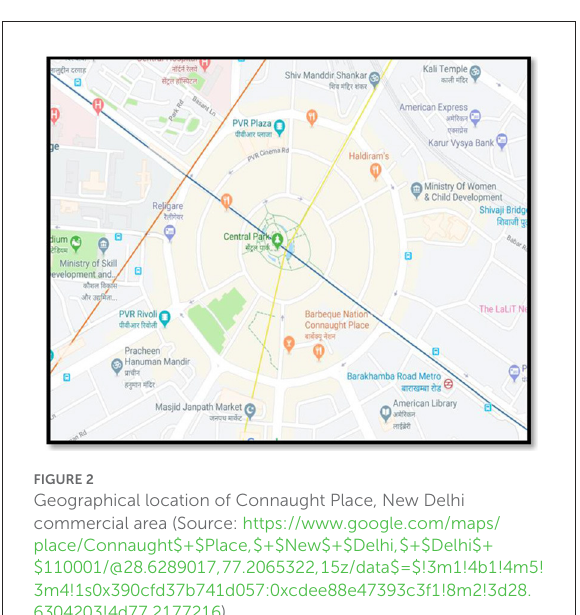
FIGURE3 Geographical location of Okhla Industrial Area, New Delhi (Source: https://www.google.com/maps/place/Okhla$+ $Industrial$+$Estate,$+$New$+$Delhi,$+$Delhi/@28.5378786, 77.2585229,14z/data$=$!3m1!4b1!4m5!3m4! 1s0x390ce3e8cacc5ef9:0xa4b8a9f9198e4d6d!8m2!3d28. 5317239!4d77.2766287